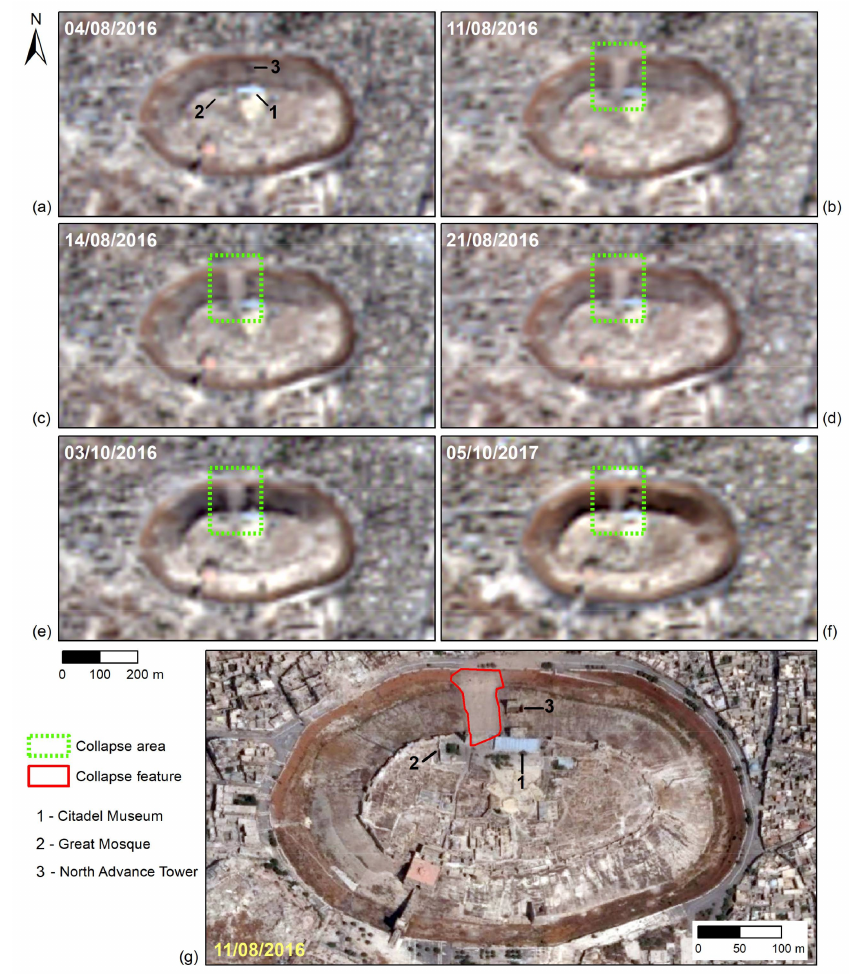
Figure 3. View of the Citadel of Aleppo (Syria) from Sentinel-2 images acquired on ( a ) 4 August 2016, ( b ) 11 August 2016, ( c ) 14 August 2016, ( d ) 21 August 2016, ( e ) 3 October 2016, ( f ) 5 October 2017, and from ( g ) very high resolution (VHR) Google Earth image taken on 11 August 2016. Labels and polygons indicate the monuments and buildings close to the area of the wall collapse that happened on 11 August 2016. Copernicus Sentinel-2 images in ( a – f ) © 2016–2017 European Space Agency—ESA; Google Earth image in ( g ) © 2018